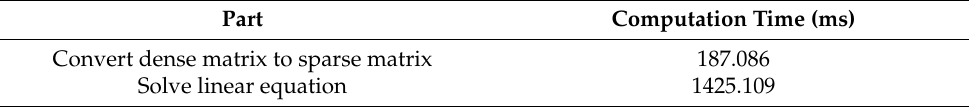
Table 4. The computation time for each process of calculate search